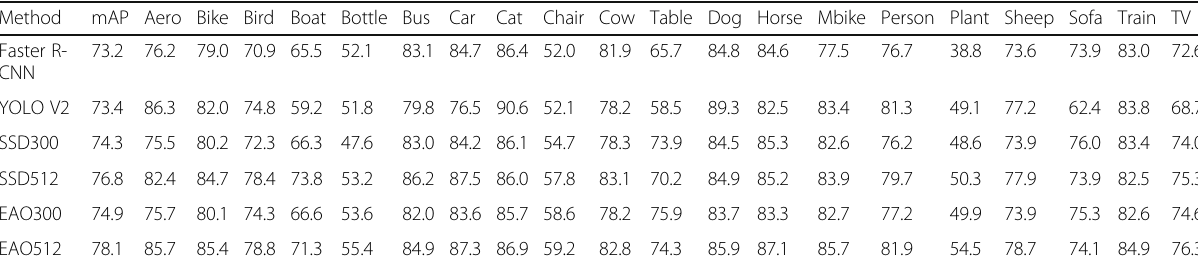
Table 1 The results of PASCAL VOC 2007 test set Method